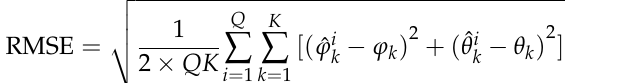
algorithm based on a uniform linear array, an ASDS